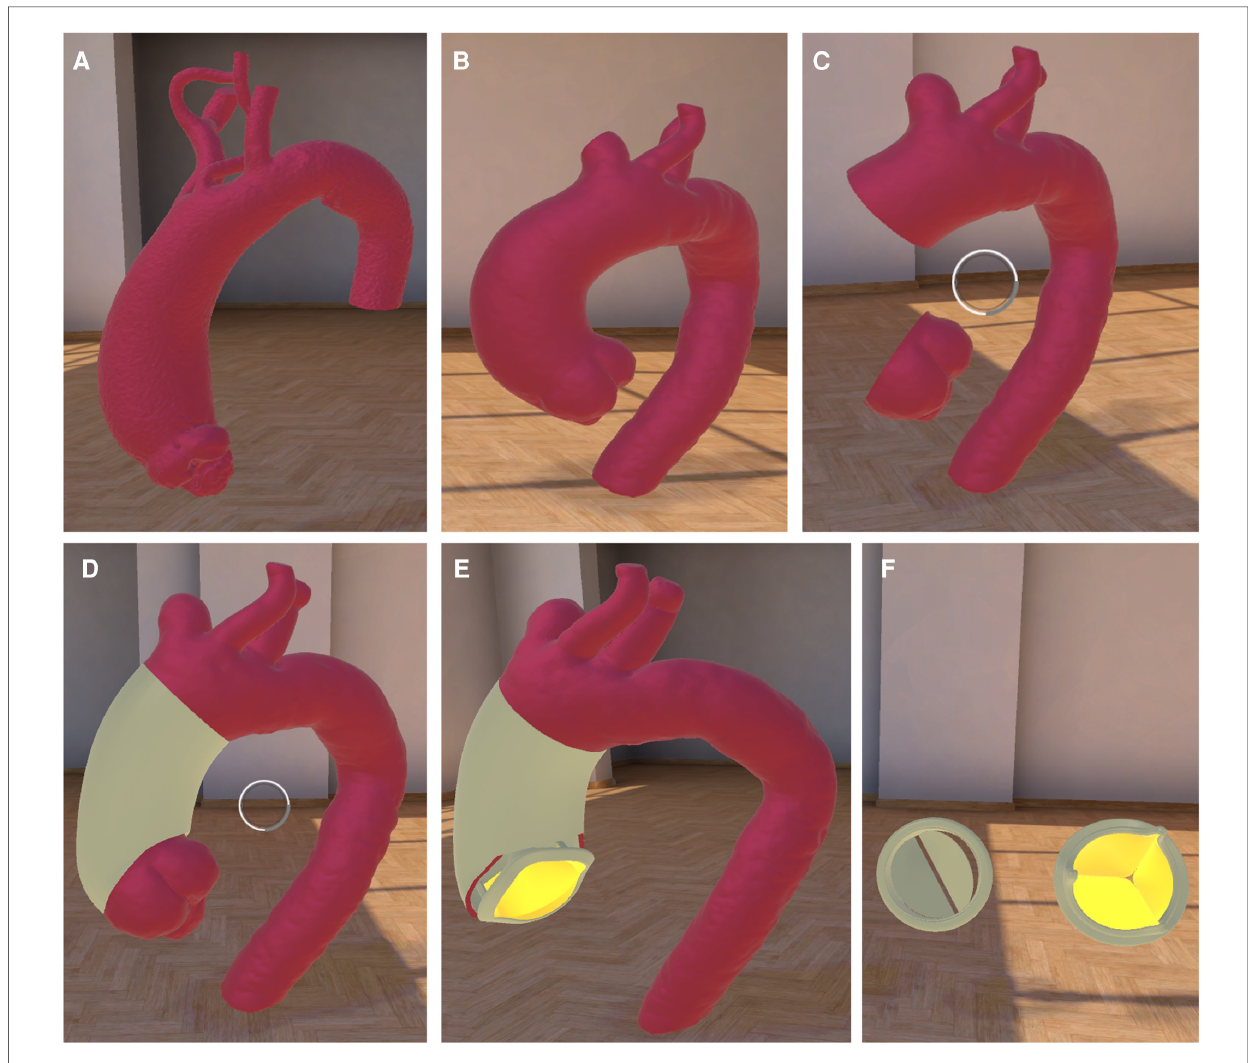
FIGURE 3 VR application for TAA . The VR environment is shown with the example of ( A ) a healthy and normal-sized ascending aorta with the aortic branch. ( B ) showing TAA with simpli fi ed surgical steps ( C ) of removing aneurysm and repair of TAA using a surgical aortic graft ( D ). ( E ) displaying the option of additional aortic valve replacement with the option to choose between ( F ) mechanical or biological valve. Round structure in image ( C,D ) shows the pointer.